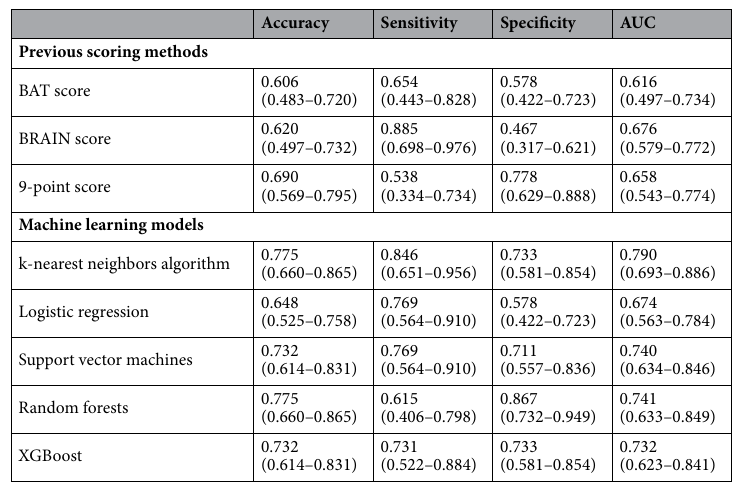
Table 4. Test characteristics of previously reported scoring methods and machine learning models in the validation cohort. Data are presented as value (95% confidence interval). AUC = area under the receiver operating characteristic